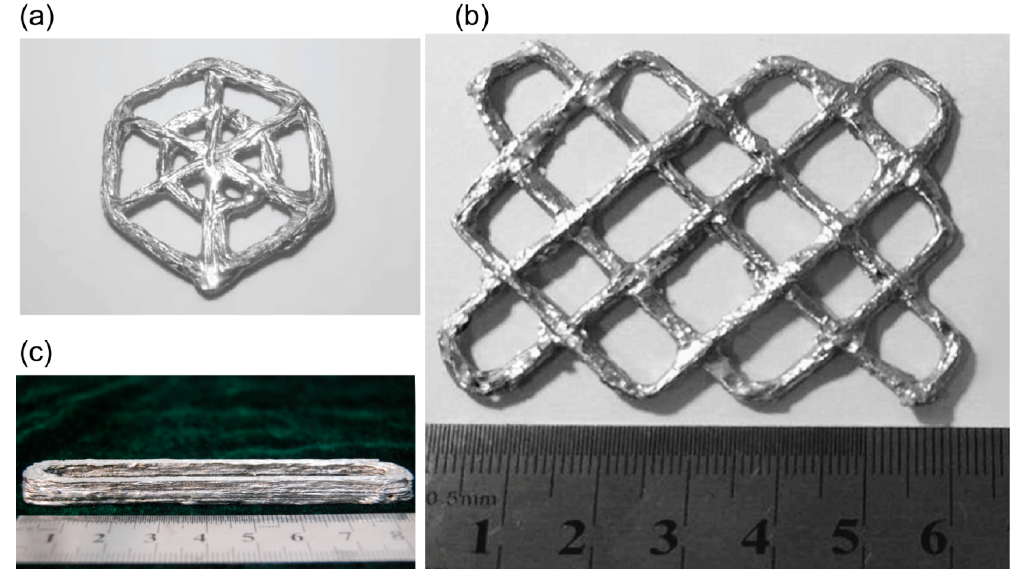
Figure 9. ( a ) Concentric hexagonal mesh grid; ( b ) Cross mesh grid; ( c ) Thin-wall part.